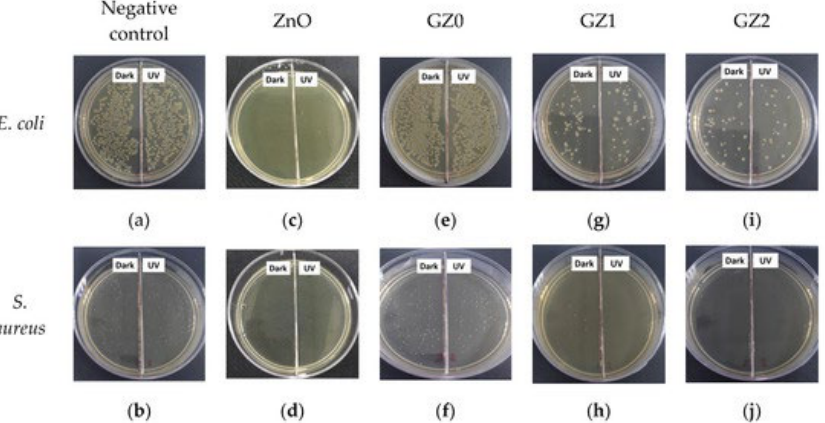
Figure 8. The photographs show the antibacterial activity of ( a , b ) negative control, ( c , d ) ZnO particles, ( e , f ) GZ0, ( g , h ) GZ1, and ( i , j ) GZ2 against S. aureus and E. coli , respectively [106]. The number of CFUs after 24 h was used to assess the antibacterial and antifungal properties of PCL-ref and PCL-ZnO (Figure 9). The number of CFUs increased by 3–4 orders of magnitude in the control sample. PCL-ref showed significant antibacterial activity compared to the control well without a sample (K) (approximately 2-log reduction in CFUs). In fungal cultures, CFUs grew slightly ( Candida parapsilosis ) or declined ( Neurospora crassa ). The PCL-ZnO sample significantly reduced Candida parapsilosis (blue column (1), CFUs and had 100% antibacterial/antifungal activity against Neurospora crassa (2), E. coli (3), and S. aureus (4) strains